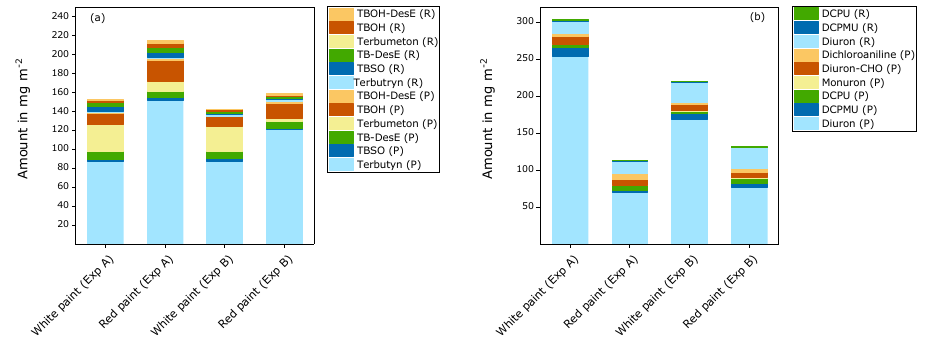
Figure 6. Mass balance of terbutryn and transformation products ( a ) and diuron and transformation products ( b ) in white and red test panels at the end of the semi-field experiment. The amounts of the transformation products are related to the initial amounts of the active substances, i.e., the initial amounts of transformed active substances were calculated and presented in the graphs. Data for the test panels (P): mean value of six sections; data for the runoff (R): sum of 83 (experiment A) and 69 (experiment B) runoff samples. Calculated original amounts for active substances: 230 mg m − 2 (experiment A) and 218 mg m − 2 (experiment B). Dichloroaniline, diuron-CHO, and monuron were only analyzed in the last 12 runoff samples.